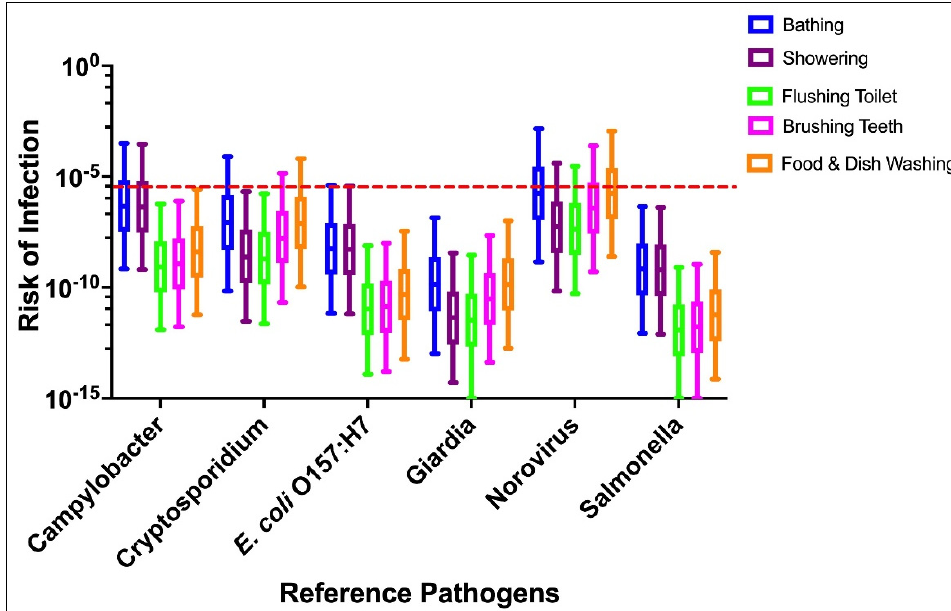
Figure 4. Daily risk of a GI infection for indirect ingestion of contaminated well water. The red dashed line represents the modified U.S. EPA daily risk threshold (1 × 10 − 6 ).